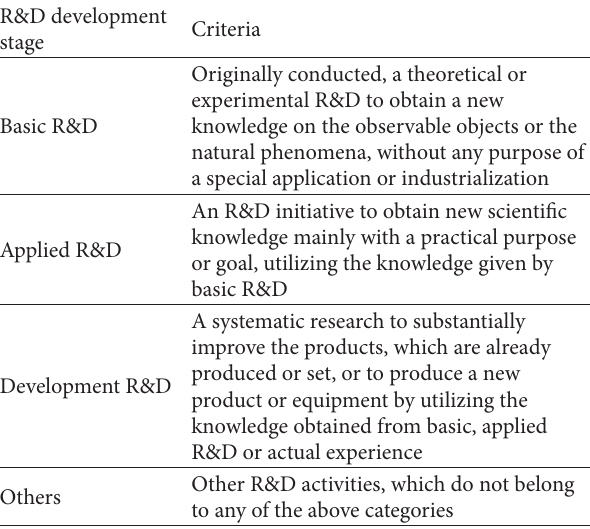
Table 1: The R&D development